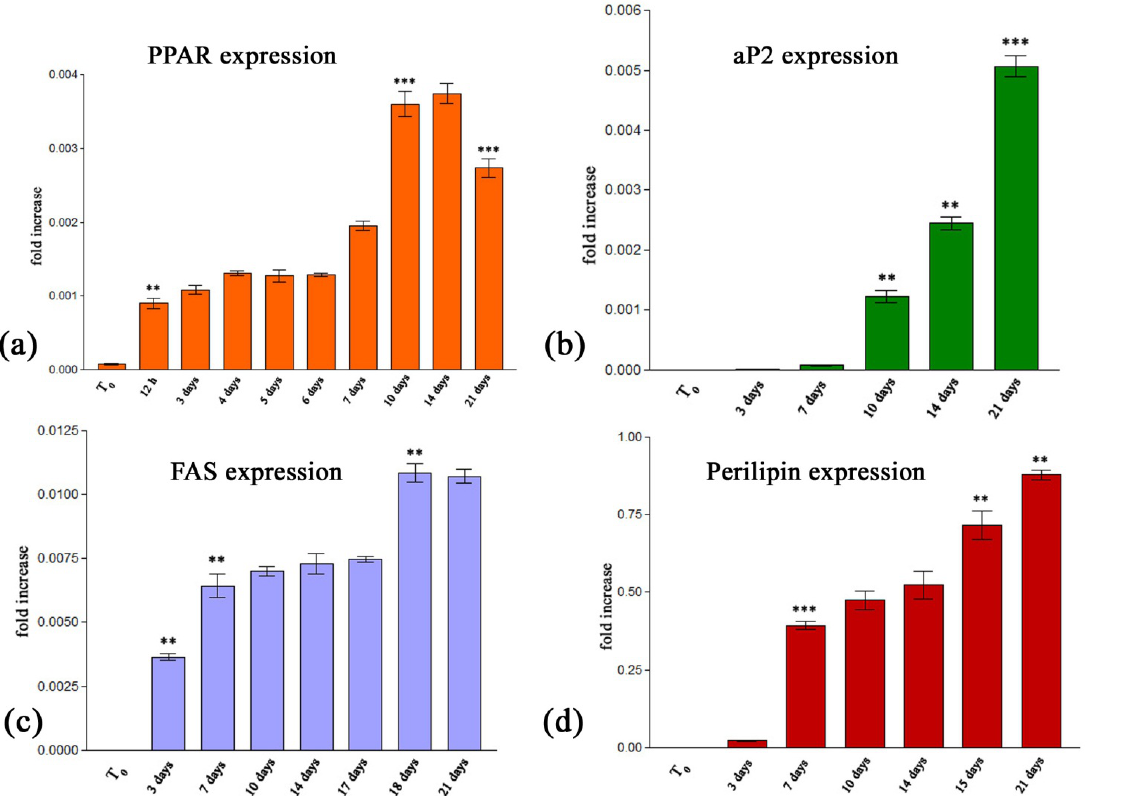
Figure 5. Gene expression profiles of ( a ) PPAR γ 2 ; ( b ) aP2 ; ( c ) FAS and ( d ) perilipin as quantified by RealTime